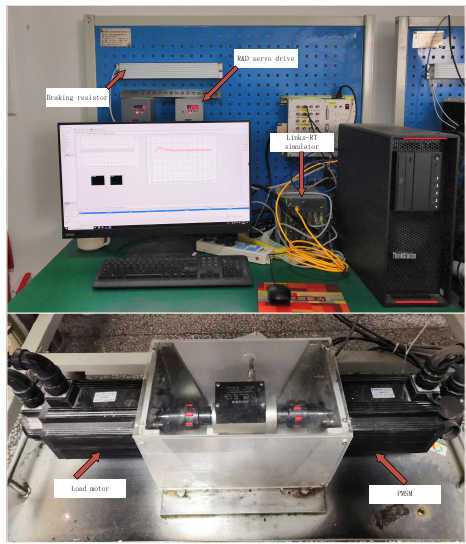
Figure 6. Experimental